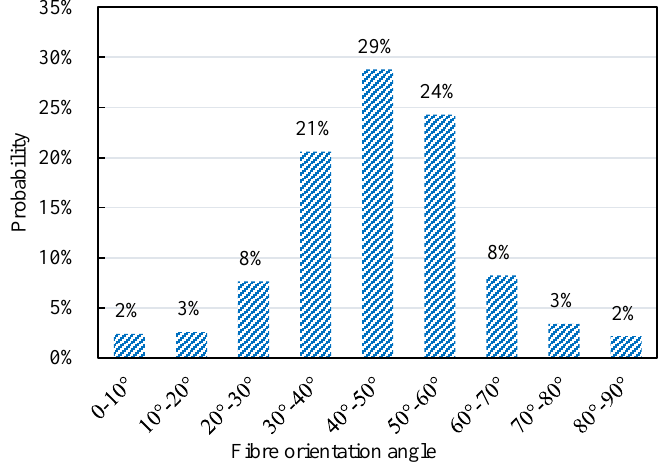
Figure 12. Distribution of fibre orientation angles.